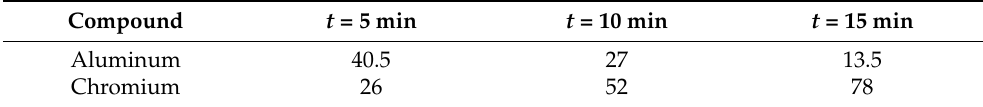
Table 3. Percentage by weight of Al and Cr in the samples of Cr 2 O 3 + (Cr,Al) 2 O 3 + 22 wt.% Cr sintered at T = 1400 ◦ C and P = 30 MPa for different lengths of sintering time t . Compound t = 5 min t = 10 min t = 15 min Aluminum 40.5